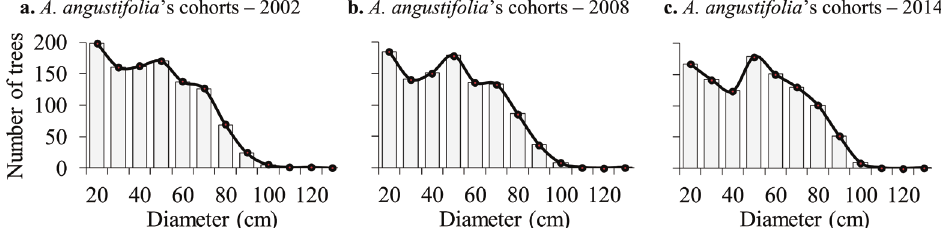
Figure 3 - Multimodal diameter distributions for Araucaria angustifolia in a mixed tropical forest